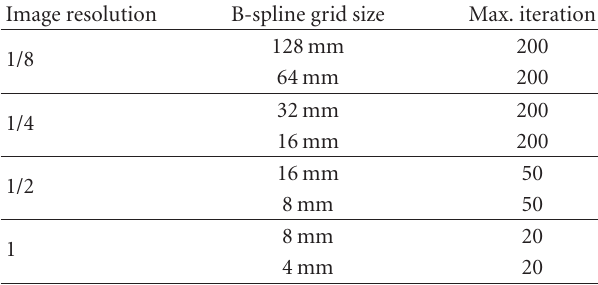
Table 2: An example multiresolution